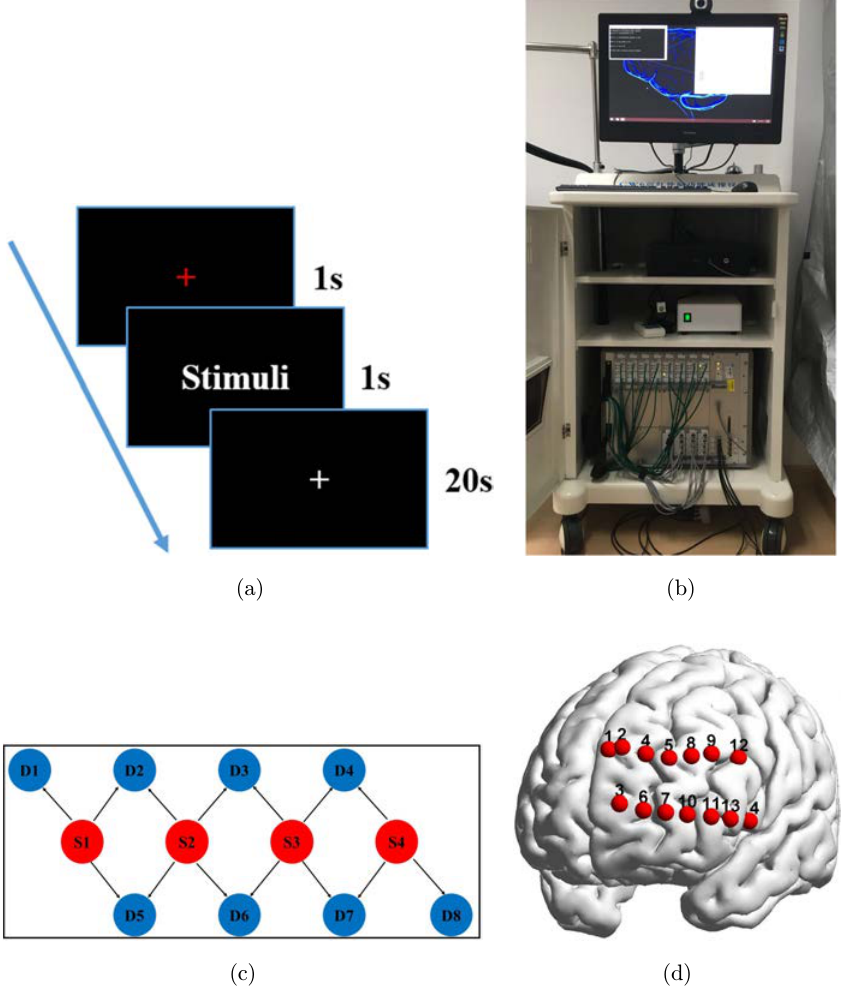
Fig. 1. (a) Schematic of the experimental design. (b) The CW6 fNIRS system. (c) The con¯gurations of the source and detector pairs. (d) Locations of the 14 fNIRS channels along the frontal cortex.